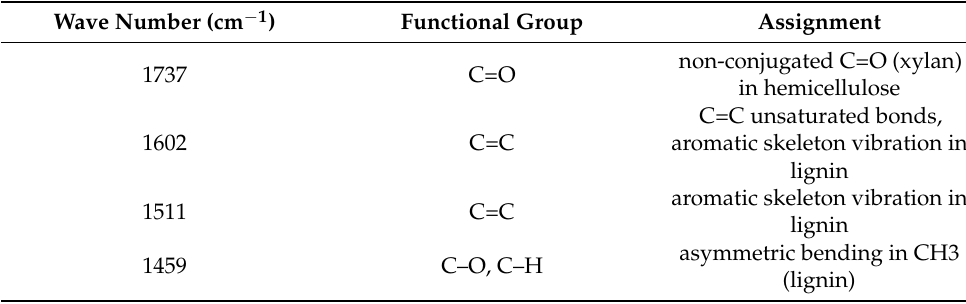
Table 1. Assignment of FTIR spectra absorption peaks of natural bamboo